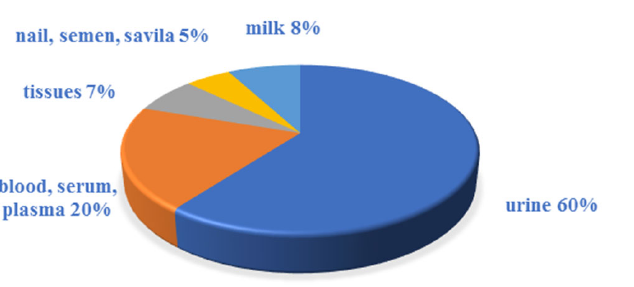
Figure 1. Biological sample types in the determination of UV filters.